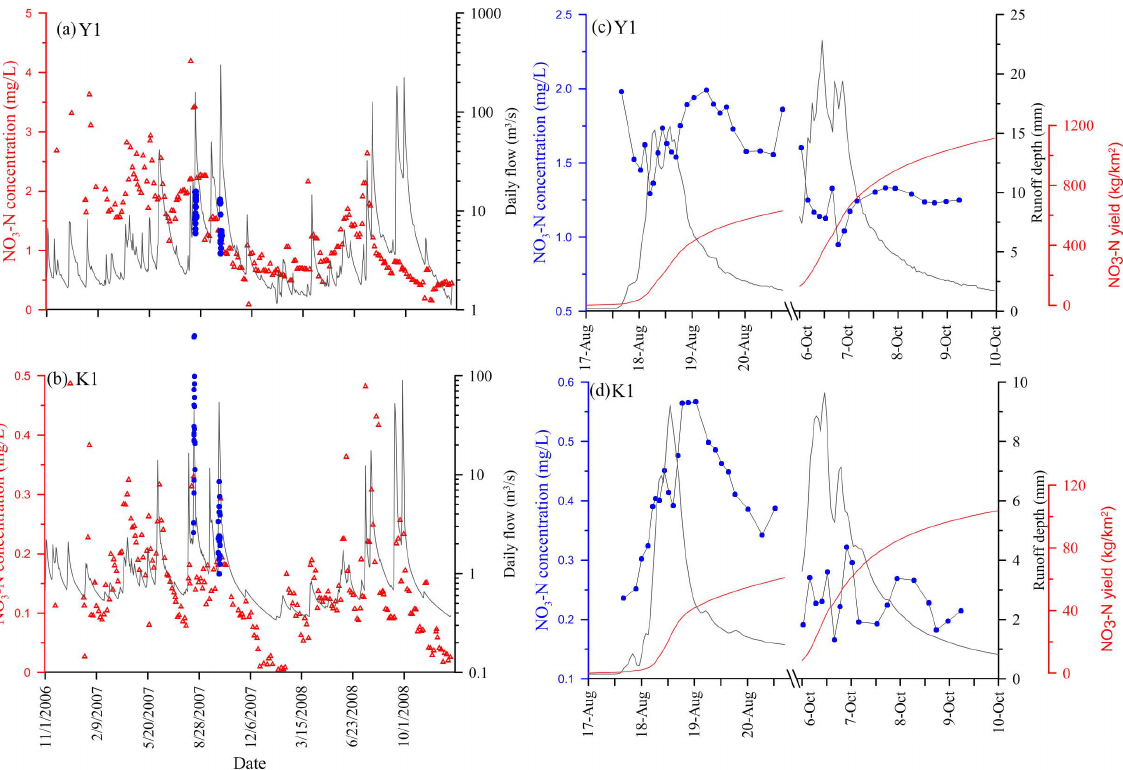
Fig. 3. The observed NO 3 -N concentration and the simulated discharge during the study period. The simulated discharge (black solid lines), NO 3 -N concentration from biweekly samples (red dots) and typhoons (blue dots) in Y1 are shown in panel (a) . The hydrograph (black solid lines), NO 3 -N concentration (black line with blue dots), and cumulative nitrate flux (red lines) for the two typhoon events in Y1 are shown in panel (c) . The same symbols for K1 station are shown in panels (b) and (d)